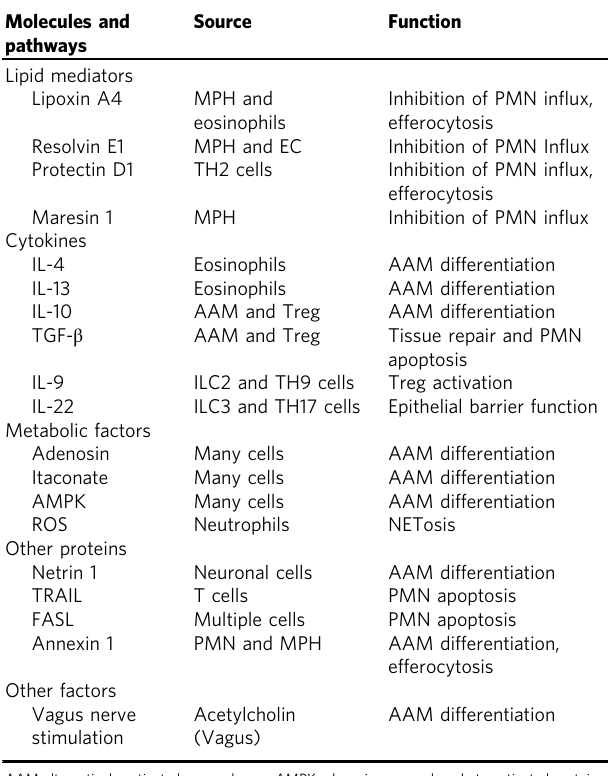
Table 1 Overview of key mediators and processes triggering the resolution of in fl ammation Molecules and pathways